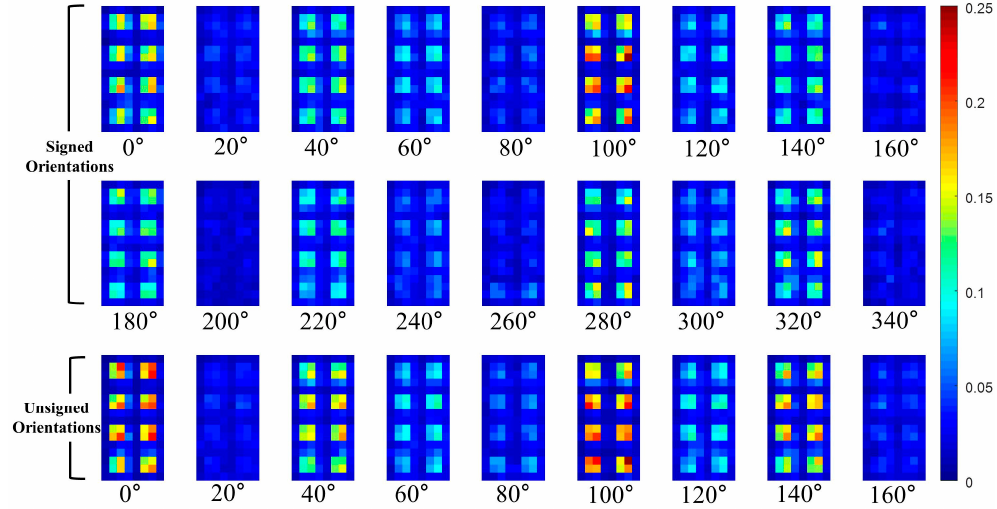
Figure 10. Average of P parts of T π HOG for non-pedestrians.